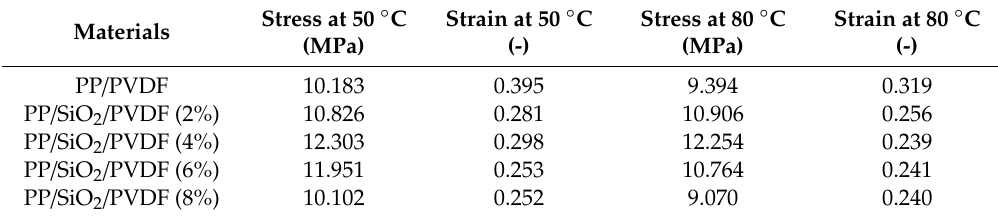
Figure 4. The stress–strain curves of composites at different temperatures: ( a ) 50 °C and ( b ) 80 °C. Table 2. Maximum stress and strain.